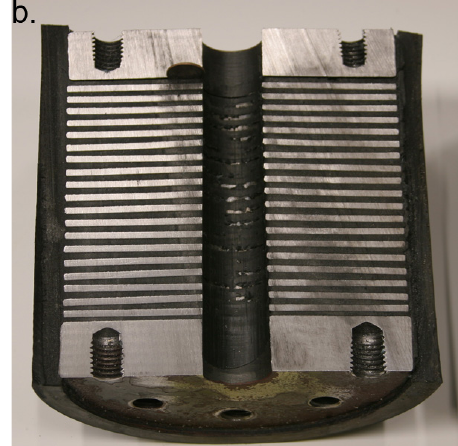
Figure 1. ( a ) Illustration of elastomeric bearing in the horizontally deformed configuration; ( b ) Photograph of elastomeric bearing